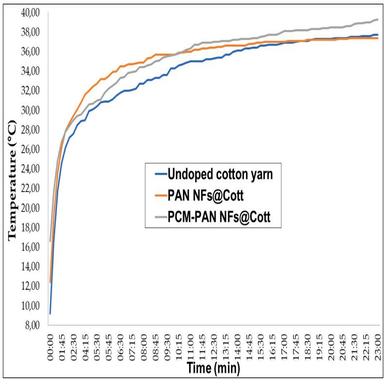
T-history results of undoped cotton yarn, PAN NFs@Cott yarn, and PCM-PAN NFs@Cott yarns.